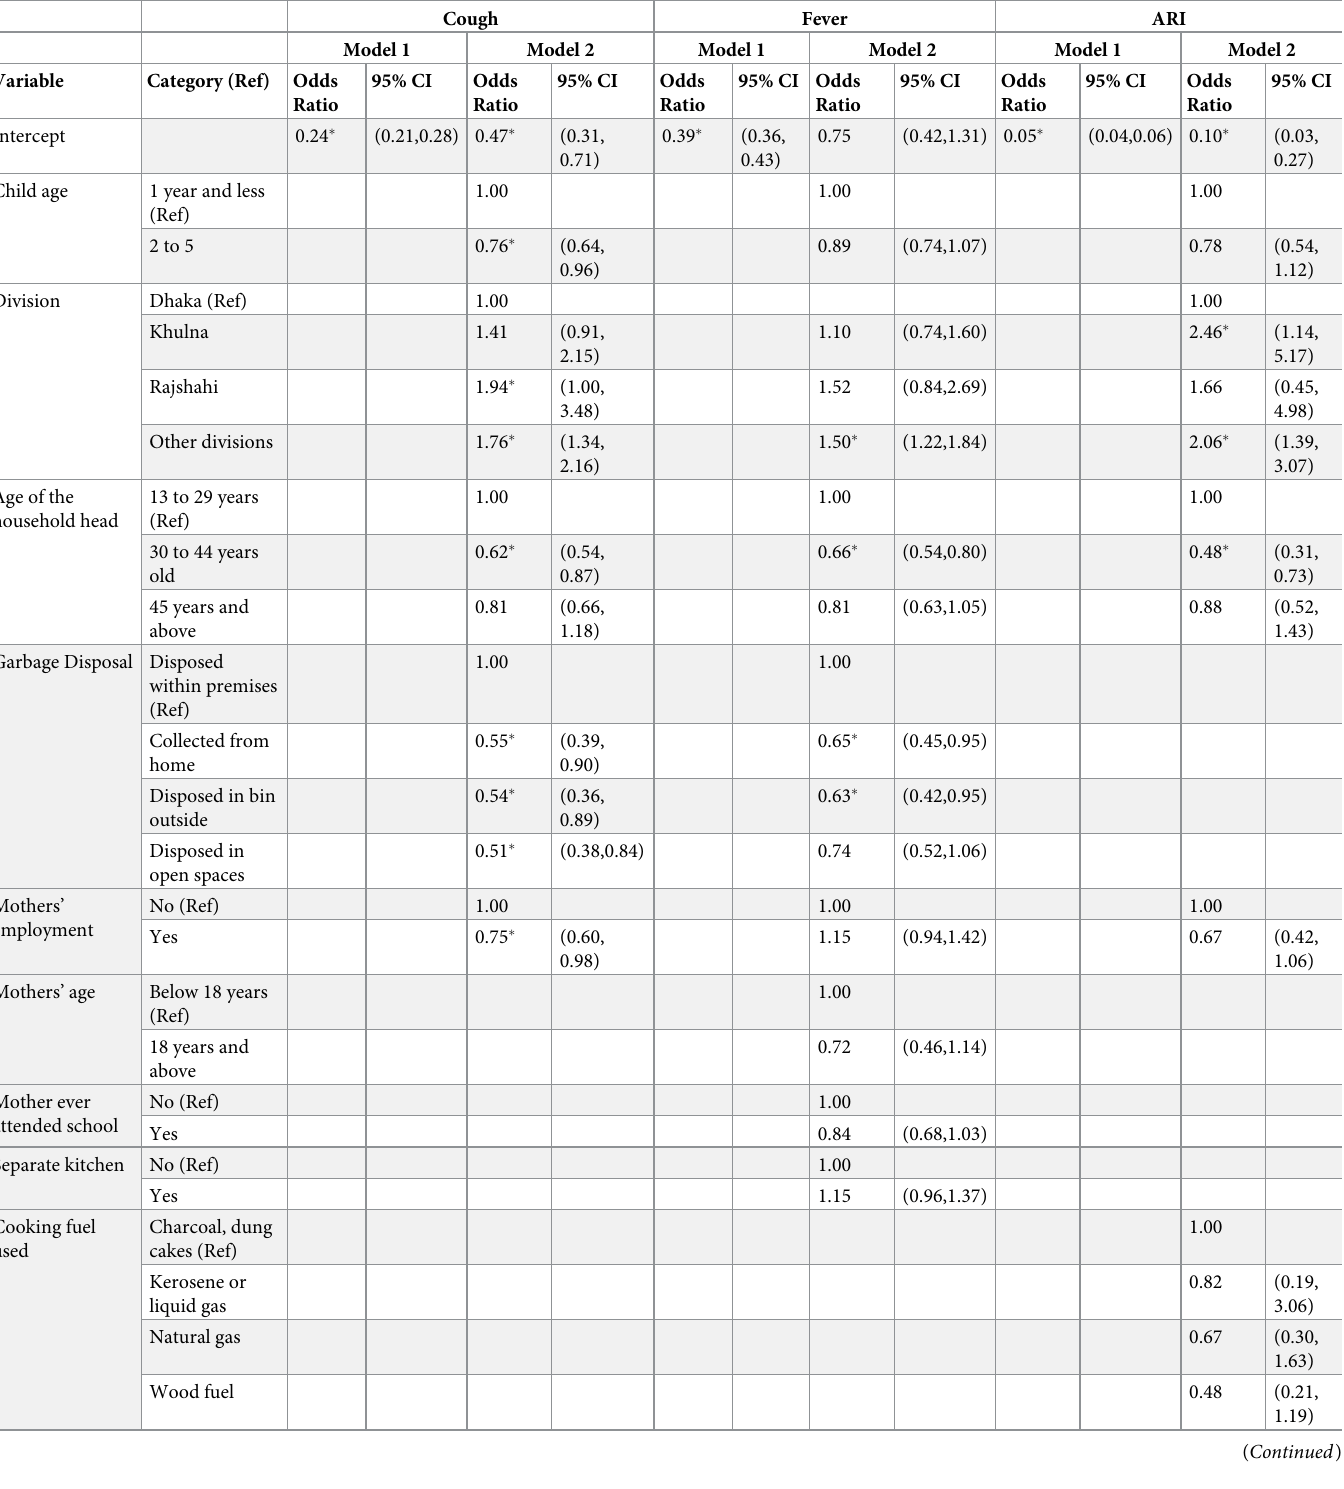
Table 1. Main effects coefficient, strata variance, area under the curve, variance partition coefficient (VPC) and proportional change in variance (PCV) for cough (Model 1 and 2), fever (Model 1 and 2), and ARI (Model 1 and